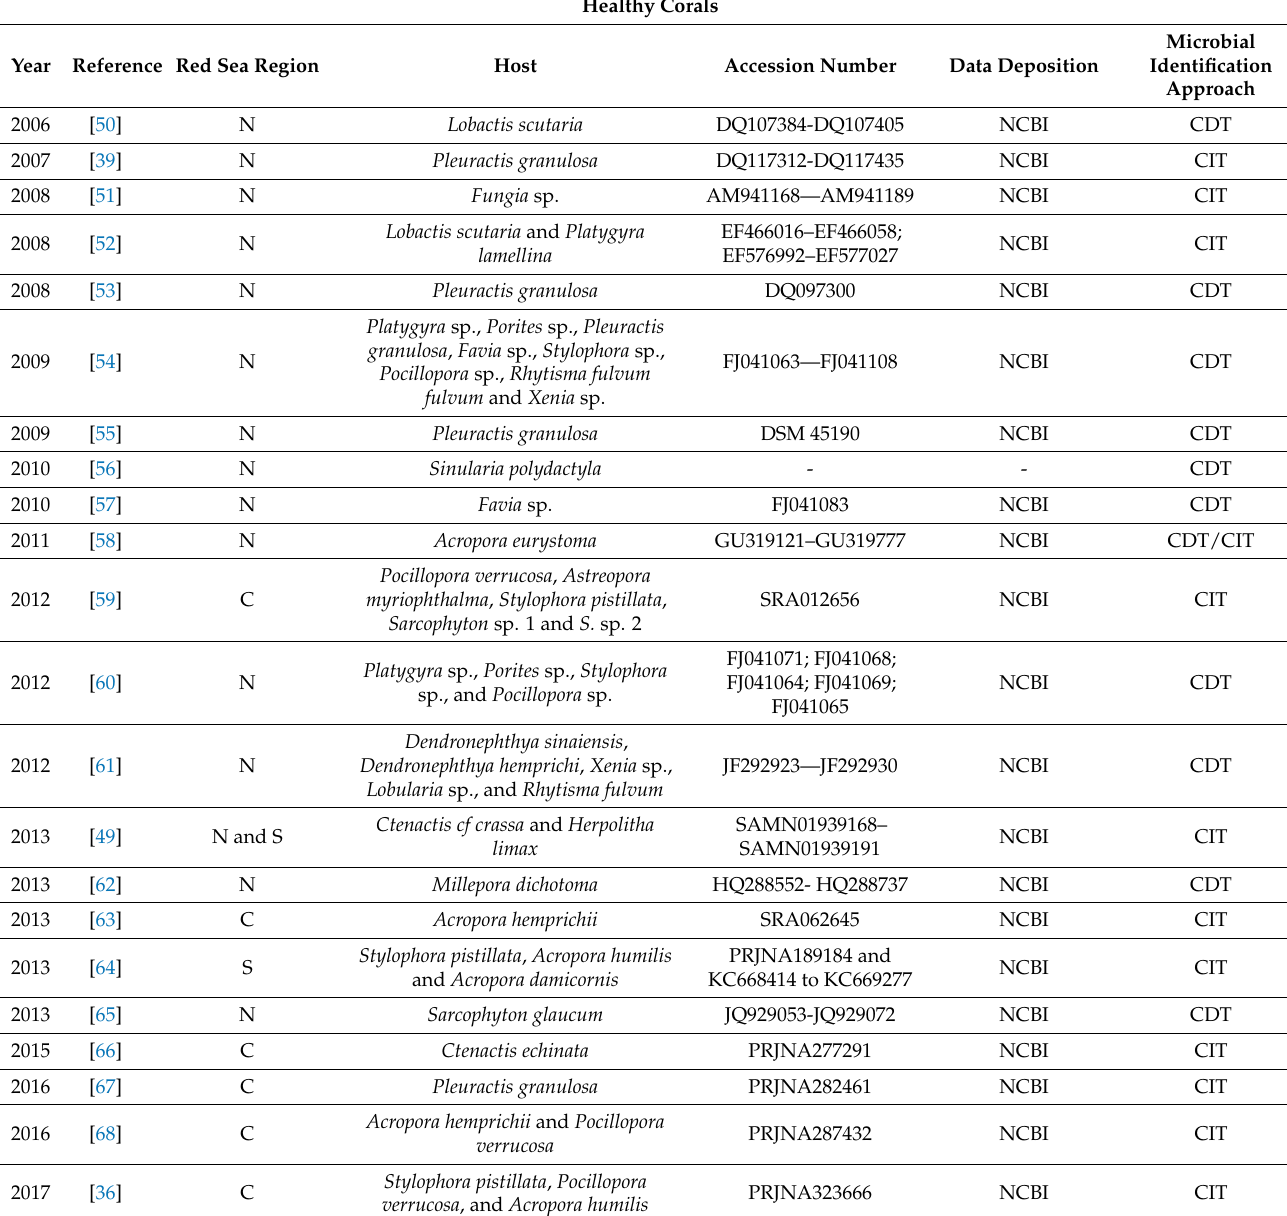
Table 1. Retrieved studies from bacterial communities associated with Red Sea corals from the PubMed and Web of Science databases. The table includes year of publication, reference, collection region (N: North; C: Central; S: South), host taxa, accession numbers, data deposition, and microbial identification approach (CDT: Culture-dependent technique; CIT: